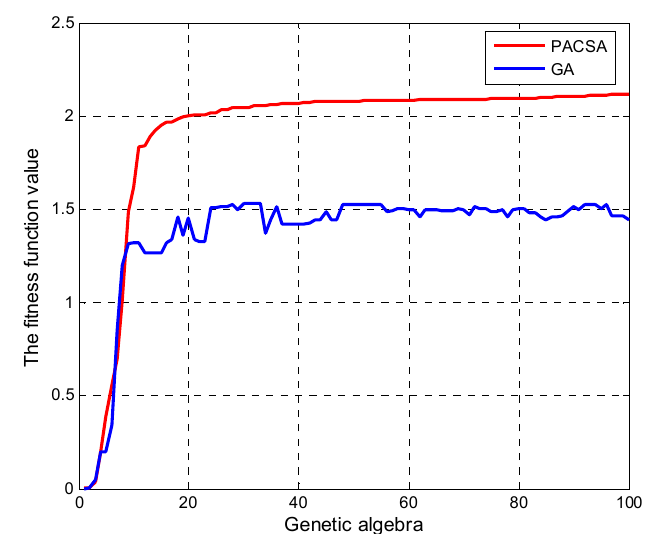
Figure 10. Vehicle model in MATLAB/Simulink.